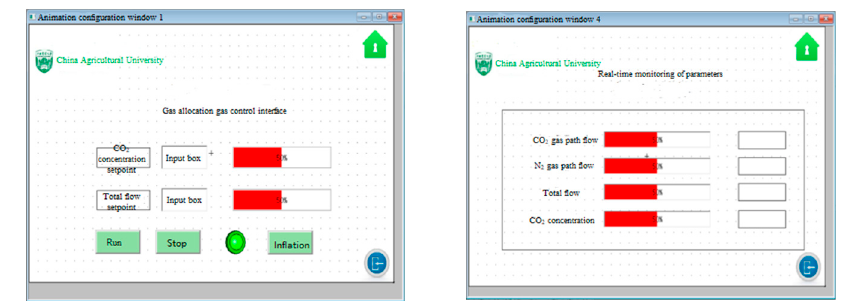
Figure 13. Actual drawing of the appearance of the gas distribution system.